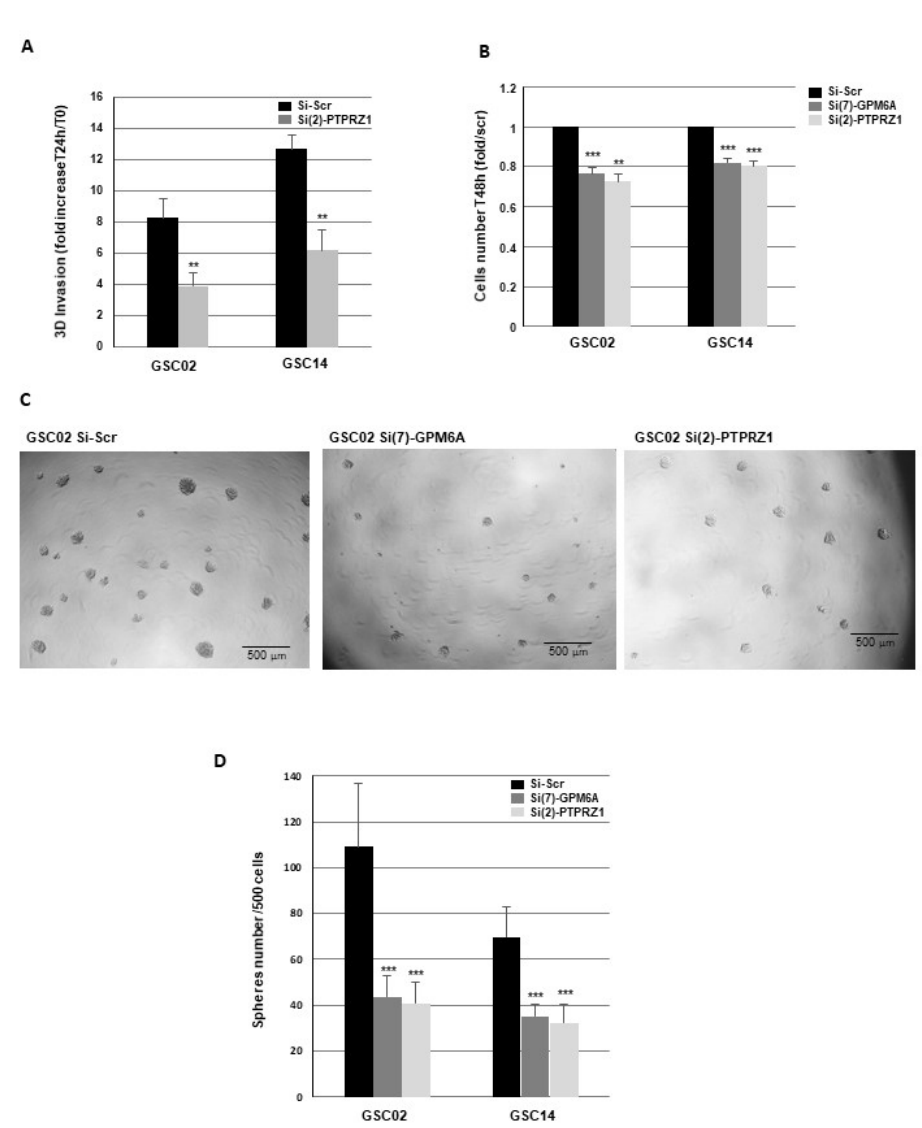
Figure 6. Targeting GPM6A or PTPRZ1 expression decreases invasion and sphere-forming ability of GBSC. ( A – D ) GBSC from different GB biopsy specimens (GSC02, GSC14) were transfected with specific PTPRZ1 siRNA (si(2)-PTPRZ1), specific GPM6A siRNA (si(7)-GPM6A), or a scramble control (si-Scr). ( A ) Following transfection, 3D invasion assays were performed as described in the Methods. ( B ) The number of cells was measured by using the cell counter Countess II FL. ( C , D ) Following the transfection, cells were seeded in 96-well plates (500 cells/well). After 8–10 days, the number of neurospheres/well was counted under the microscope. ( C ) Micrographs from representative fields were taken ( × 20). ( A , B , D ) Quantifications of 3 experiments are presented as means ± SD. *** p < 0.001; ** 0.001 < p <